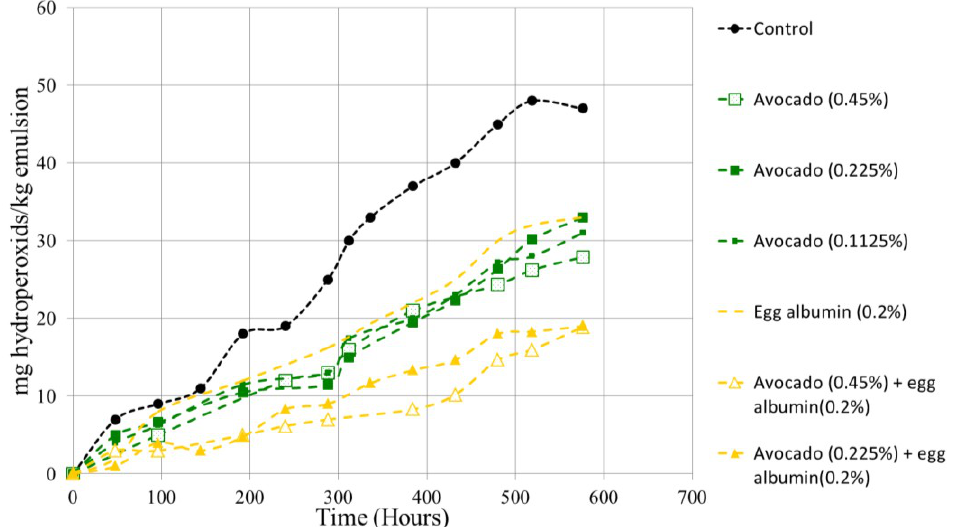
Figure 3. Peroxide values vs. time in the